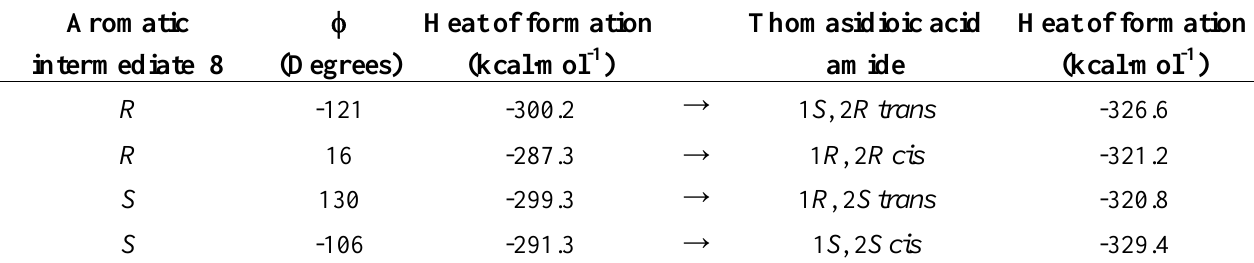
Table 5. Heat of formation of conformers of the aromatic intermediate 8 , obtained for two different values of φ angle (see Scheme 3), and of the corresponding Thomasidioic acid amide obtained after the ring closure computed at the semiempirical PM3 level of